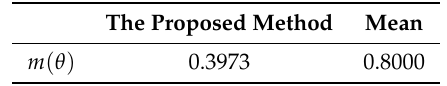
Table 14. The belief measure of the uncertainty of the criteria.